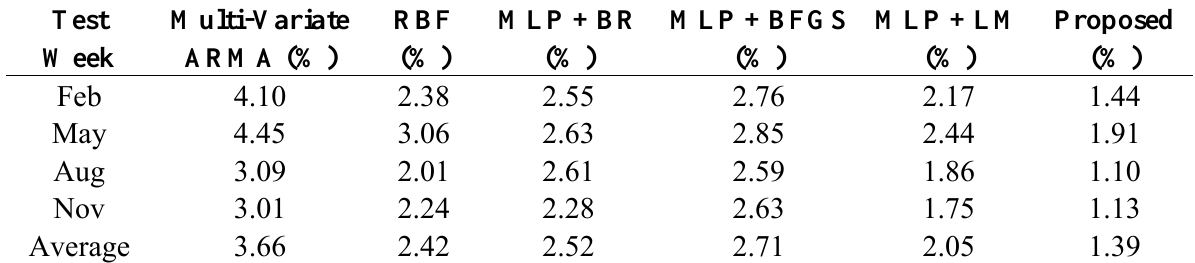
Table 1. Comparison of the proposed hybrid forecast engine with five other prediction methods for day-ahead STLF of the PJM test case in the four test weeks of year 2009 (the reported results are in terms of MAPE